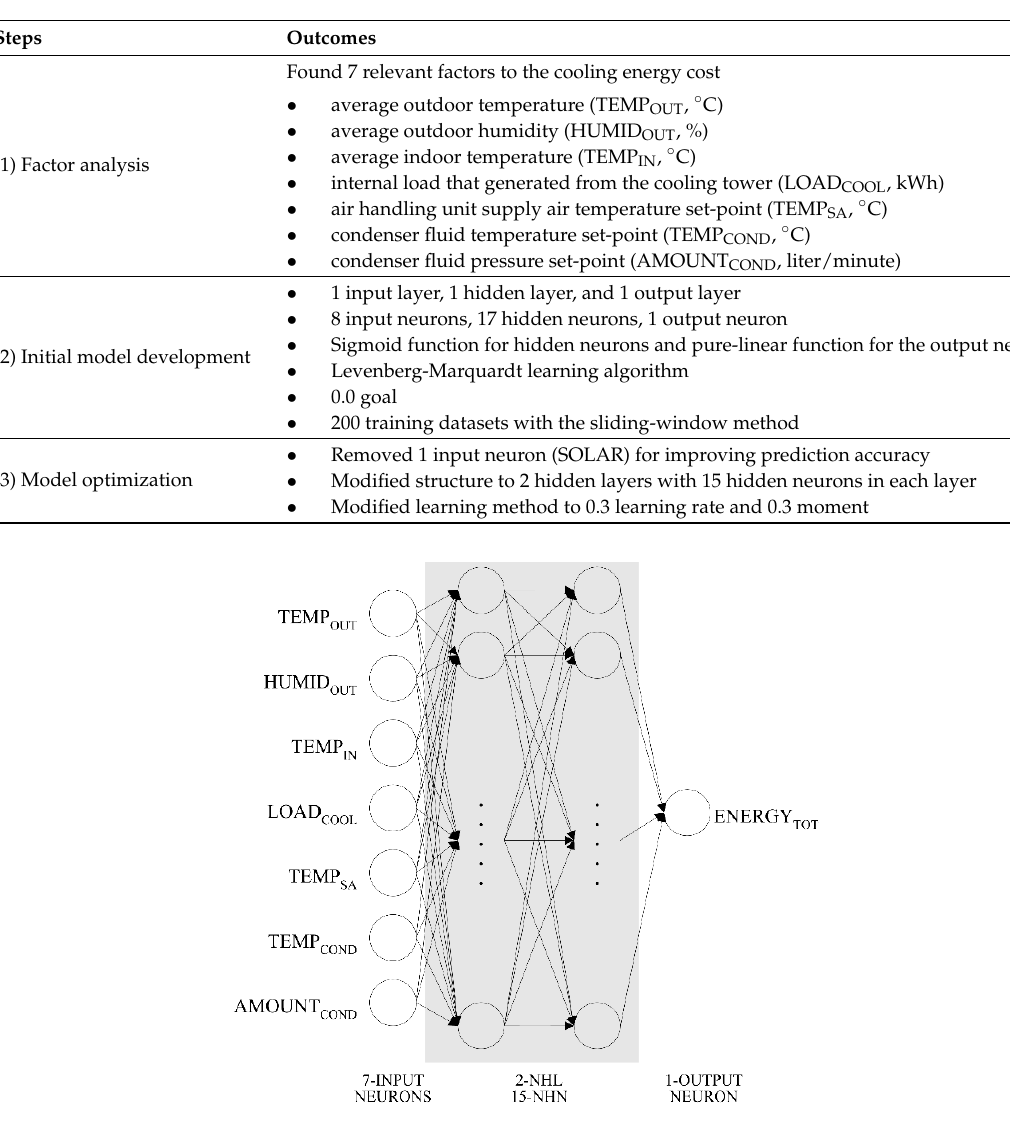
Table 1. Process and outcomes for developing an artificial neural network (ANN) model.